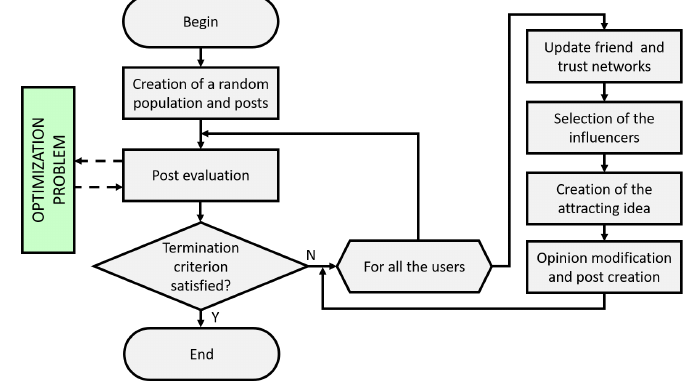
Figure 4. Flowchart of social network